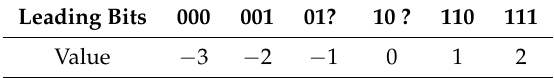
Figure 1. Generic posit format for normal Posit cases. ES, exponent width. Table 1. The leading bits of the regime and corresponding